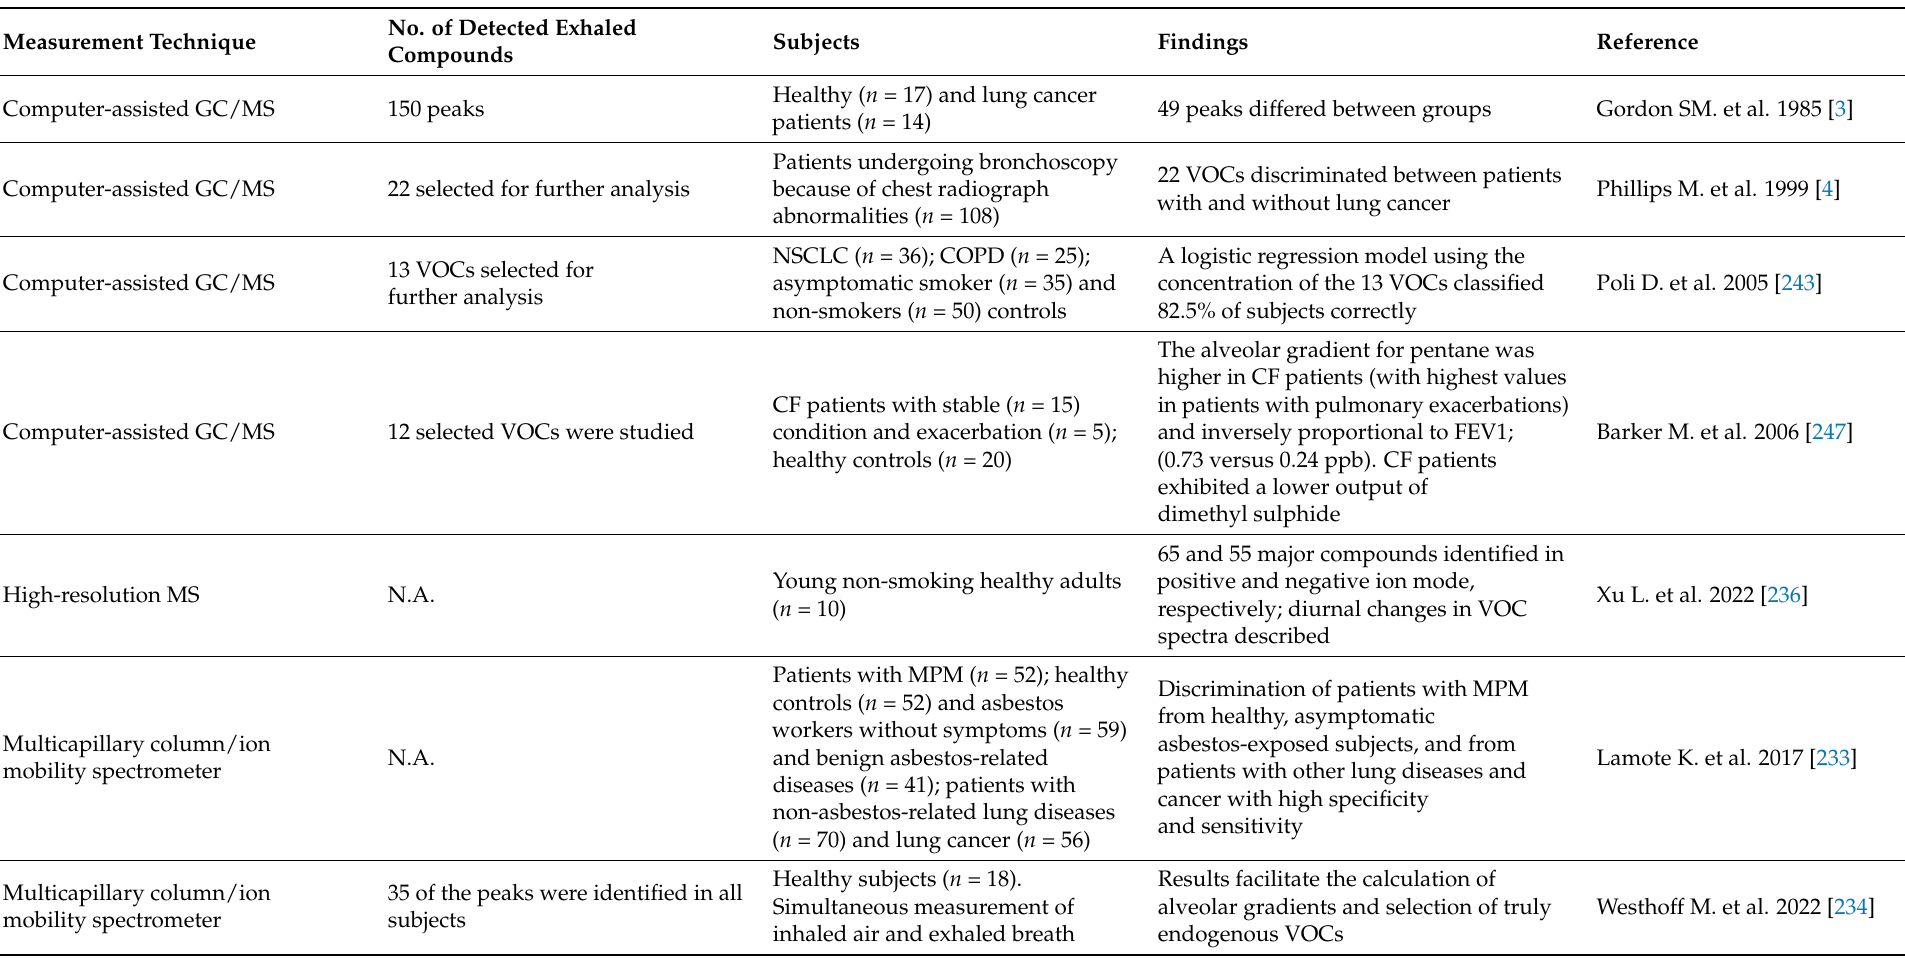
Table 3. Conventional and novel spectrometry-based detection approaches to identify VOC patterns with potential discriminative value in the diagnosis of